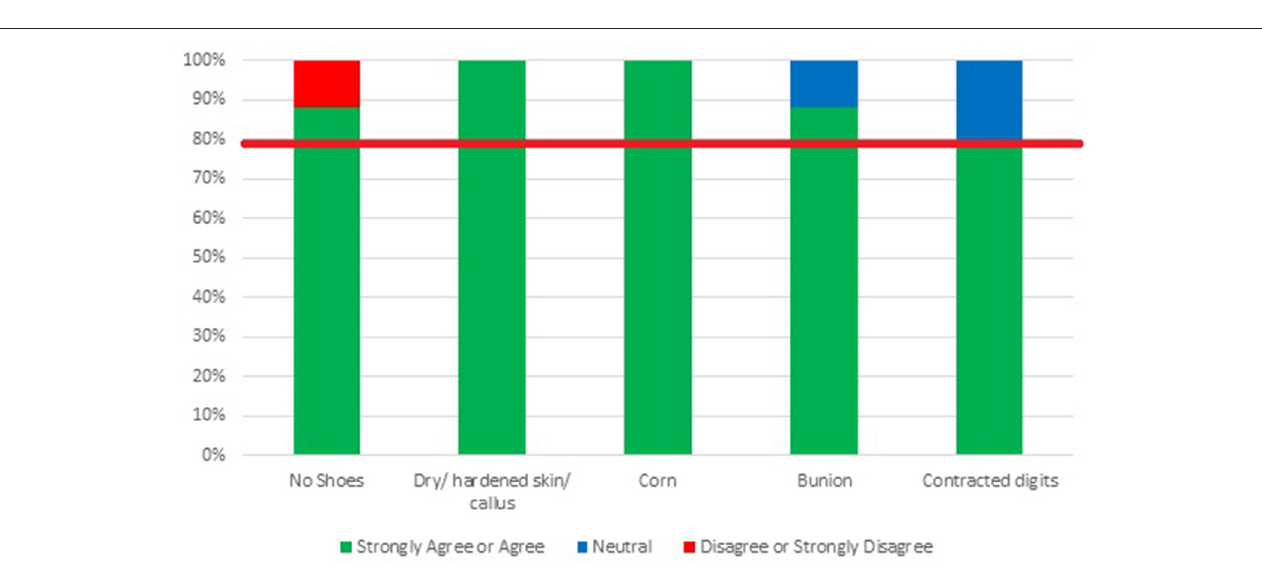
FIGURE 3 | Results of modified Delphi-Round 3: expert opinion regarding the inclusion of items on the Final Feet/Footwear-Related Fall Risk Screening Tool. Items in this round were only assessed if the agreement was not met in Round 2.